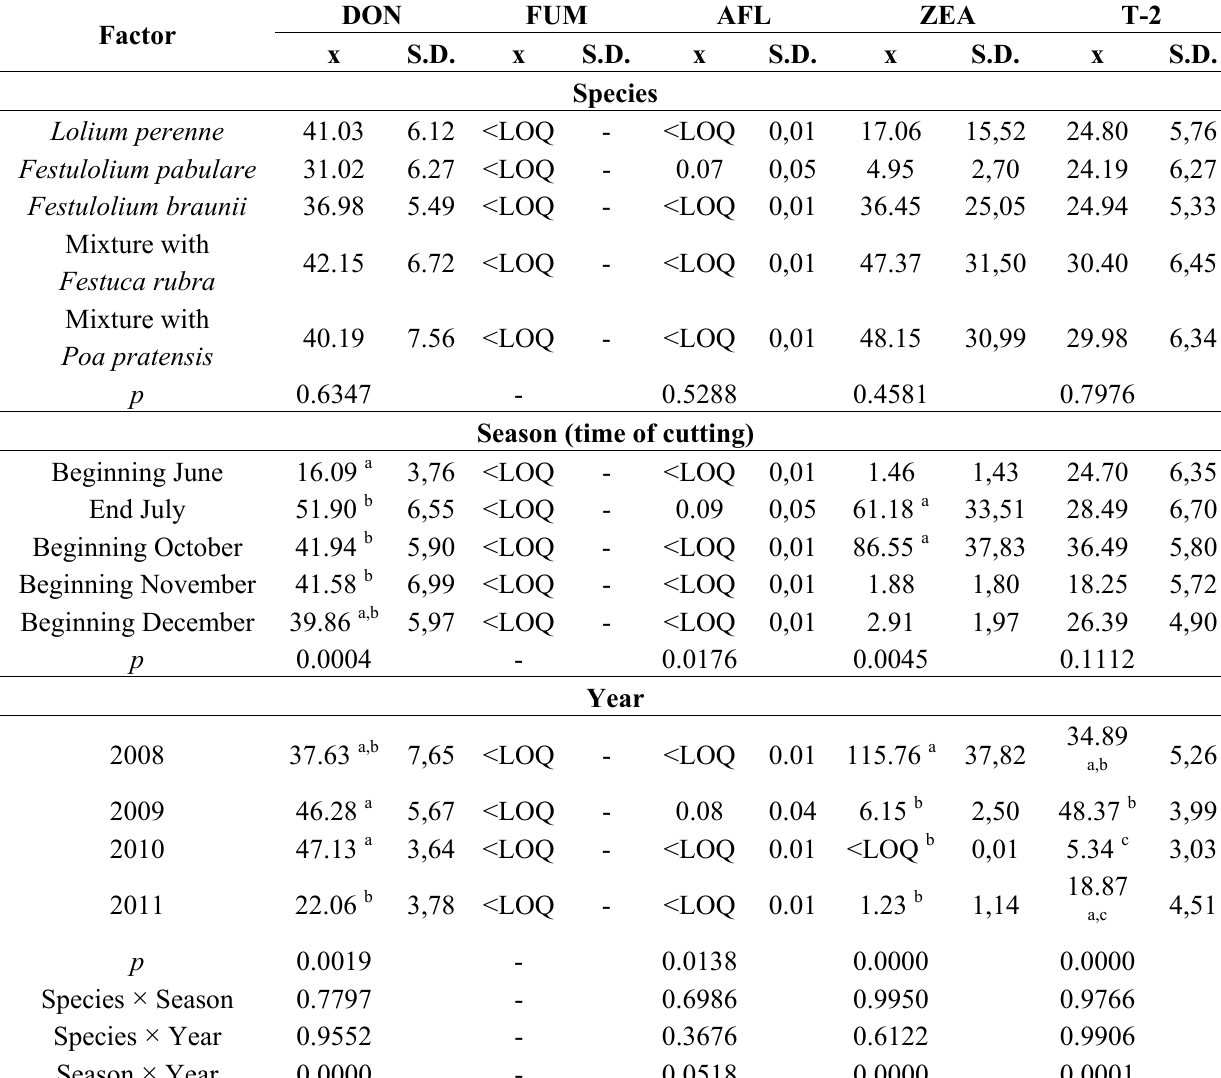
Table 1. Influence of species, season (time of cutting) and year on the content (ppb) of deoxynivalenol (DON), fumonisin (FUM), aflatoxin (AFL), zearalenone (ZEA) and T-2 toxin (T-2) in fresh-cut material of